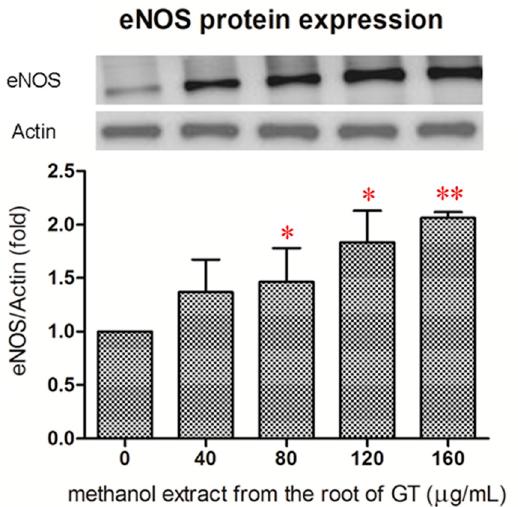
Figure 3. Effect of the R/M GTE on eNOS protein expression in HUVECs. HUVECs was treated with R/M extract for 24 h. Total eNOS protein content was determined by Western blot analysis, using β -actin as an internal control. Data were obtained from four replicate experiments, and are expressed as mean ± standard deviation. A significant difference from the vehicle was indicated as * p < 0.05 or ** p < 0.01 (Student’s t -test).